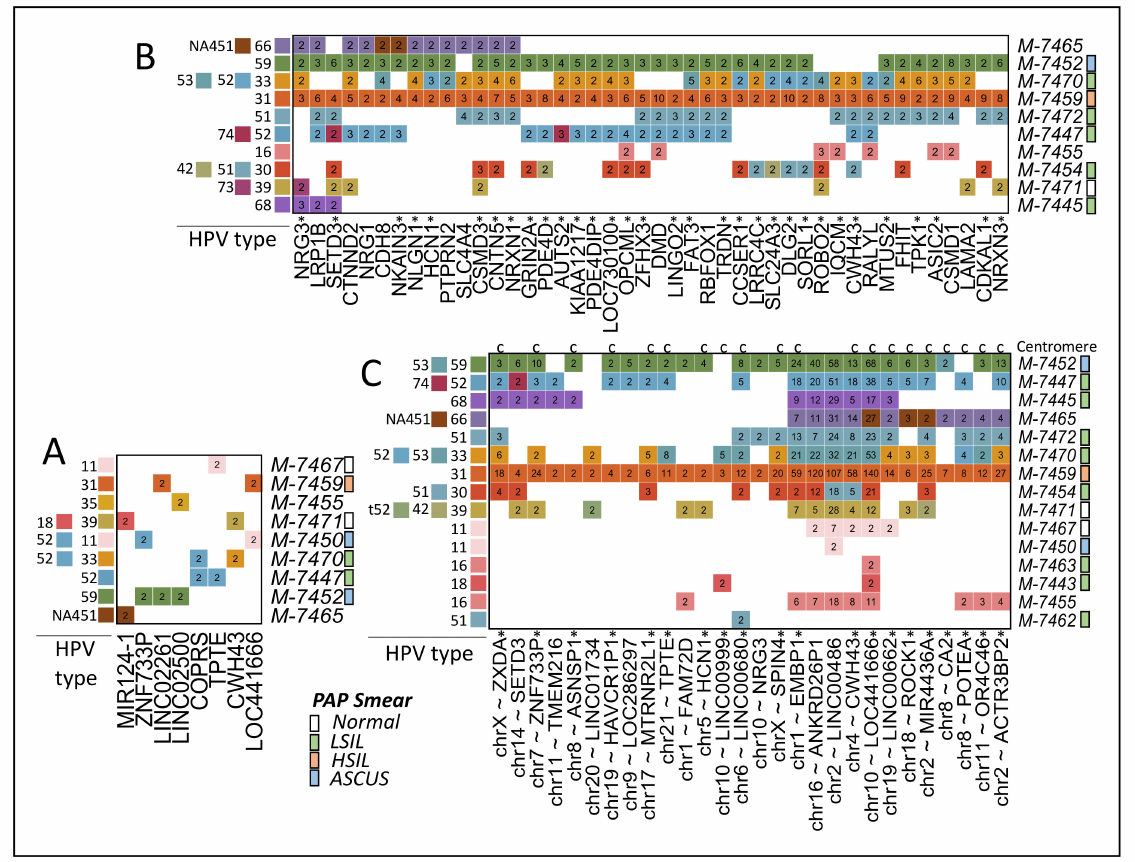
Figure 5. Multiple reads or integrations. ( A ) Reads in genes showing more than 1 read in the same integration point in 2 or more samples (targets in human region and HPV are the same). ( B ) Reads or integrations in coding genes found in 4 or more samples where HPV target type or precise human integration point may differ. Gene region includes 5 kb in 5 (cid:48) and 3 (cid:48) of the canonical transcript. Genes marked with a star “*” do not show records of co-occurrence with HPV in abstracts from PubMed. ( C ) Reads or integrations in non-coding regions close to genes in 3 or more samples where HPV target type or precise human integration point may differ. Regions marked with “*” and “c” are close to centromeres. Pap smear results per samples are